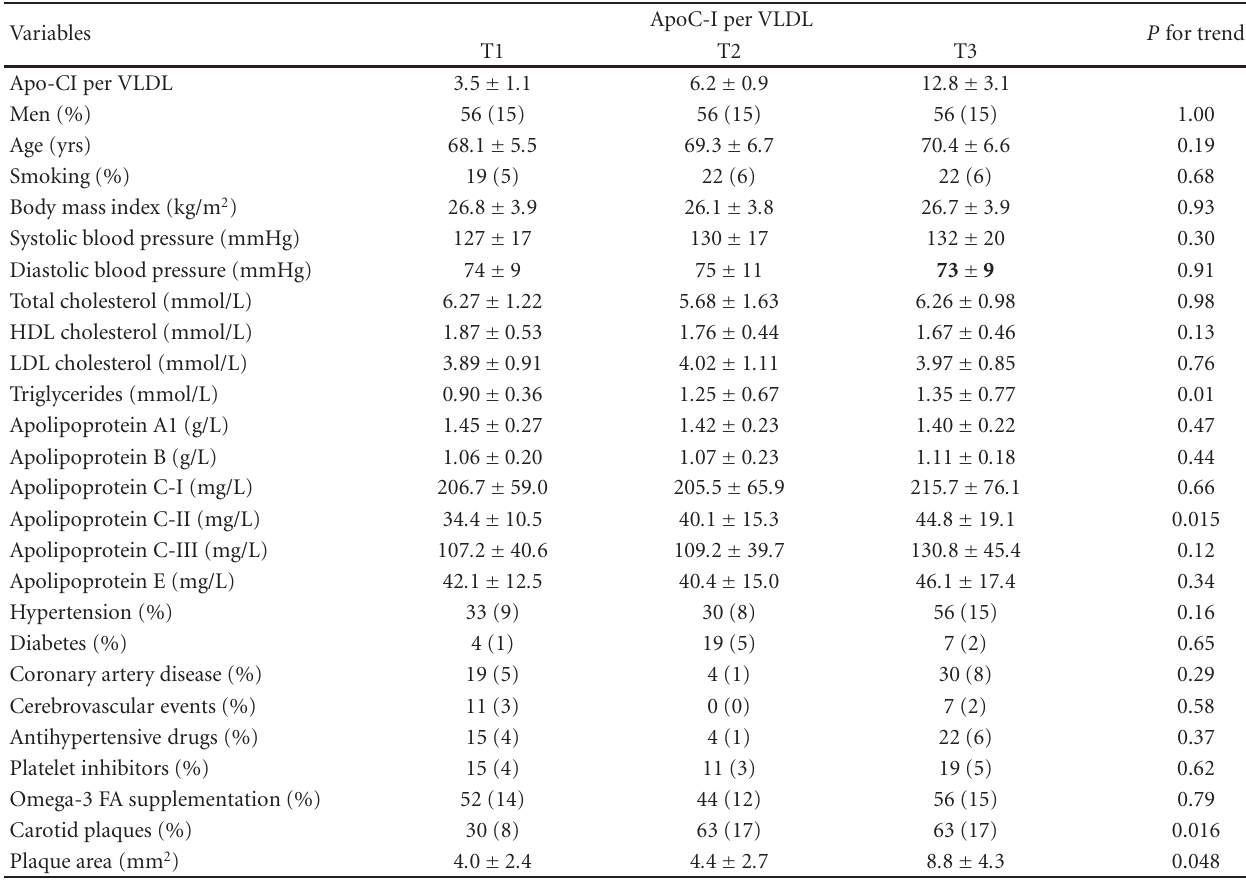
Table 1: Characteristics of study participants. Characteristics of subjects included in the study across tertiles of apoC-I molecules per VLDL particles ( n = 81) under fasting conditions. Values are means ± 1 SD or percentage with number in